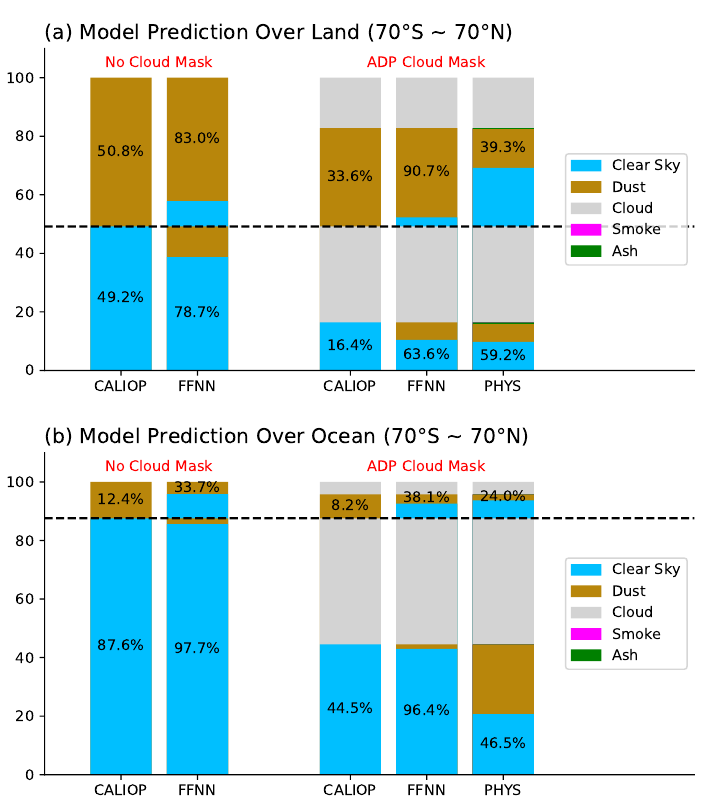
Figure 5. Comparison of CALIOP product, FFNN prediction, and PHYS prediction. First, two stacked bar graphs show the comparison between CALIOP and FFNN. Numbers in CALIOP bar show the percentage of dust and non-dust over the total number of CALIOP data, while the numbers in FFNN bars represent the conditional accuracy of the FFNN regarding CALIOP defined dusty or clear. Three stacked bars on the right depict the comparison between CALIOP, FFNN, and PHYS under the PHYS ADP cloud mask. Panel ( a ) shows the comparison over land, while panel ( b ) shows the comparison over the